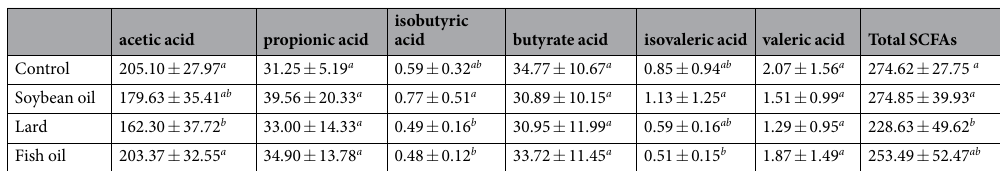
Table 2. SCFAs levels in the fermentation liquid in response to different dietary fats (mmol/L). a , b Means with different superscripts differed significantly (P < 0.05). The numerical values were composed of the means and the standard